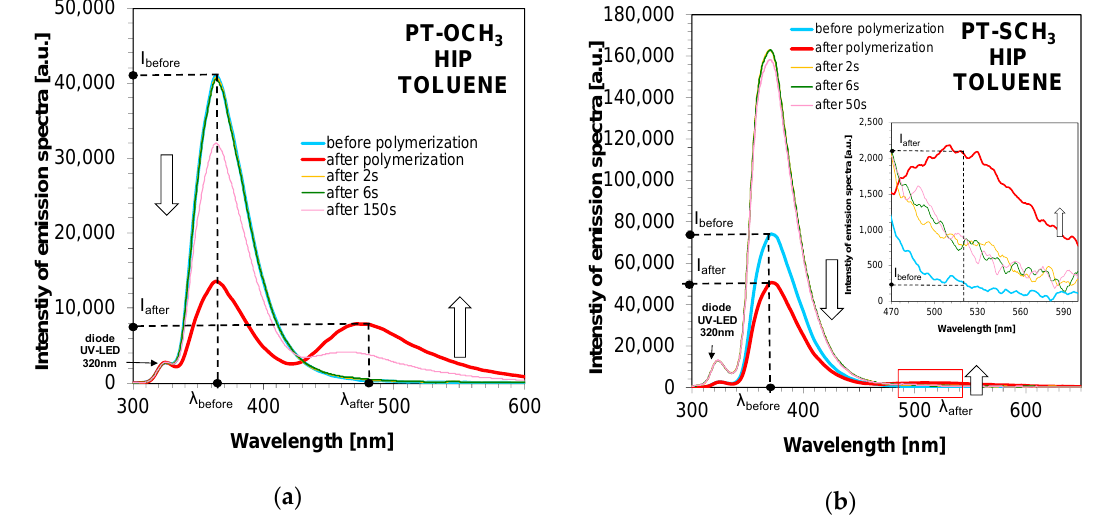
Figure 16. Changes in emission spectra during irradiation at 320 nm of the system containing the toluene, HIP photoinitiator and ( a ) the PT-OCH 3 sensor and ( b ) the PT- SCH 3 sensor.